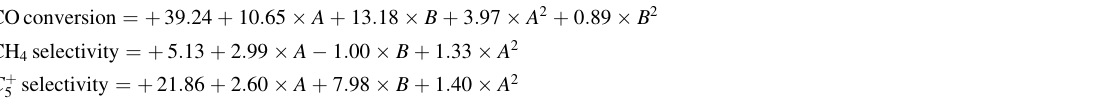
Table 3 The obtained RSM models in coded version